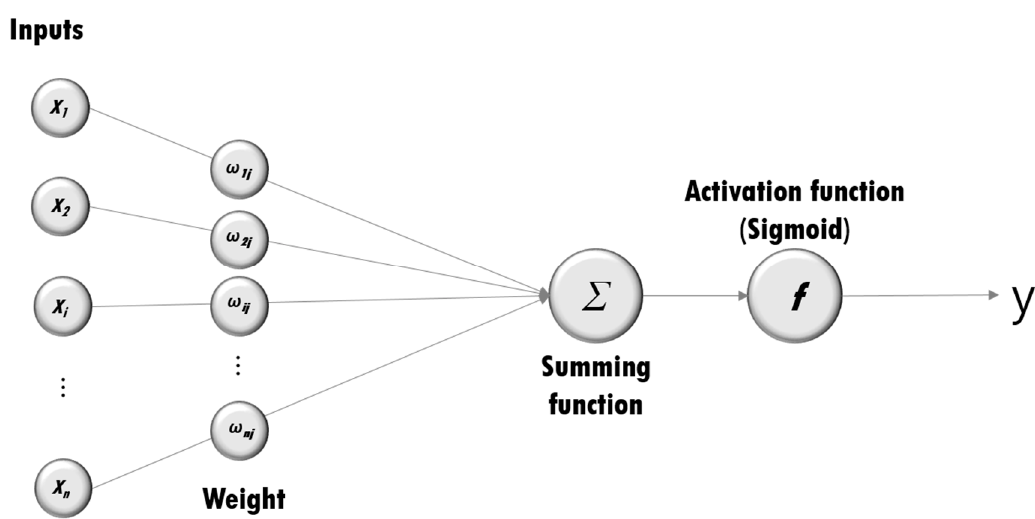
Figure 2. Schematic diagram of multilayer perceptron (MLP).